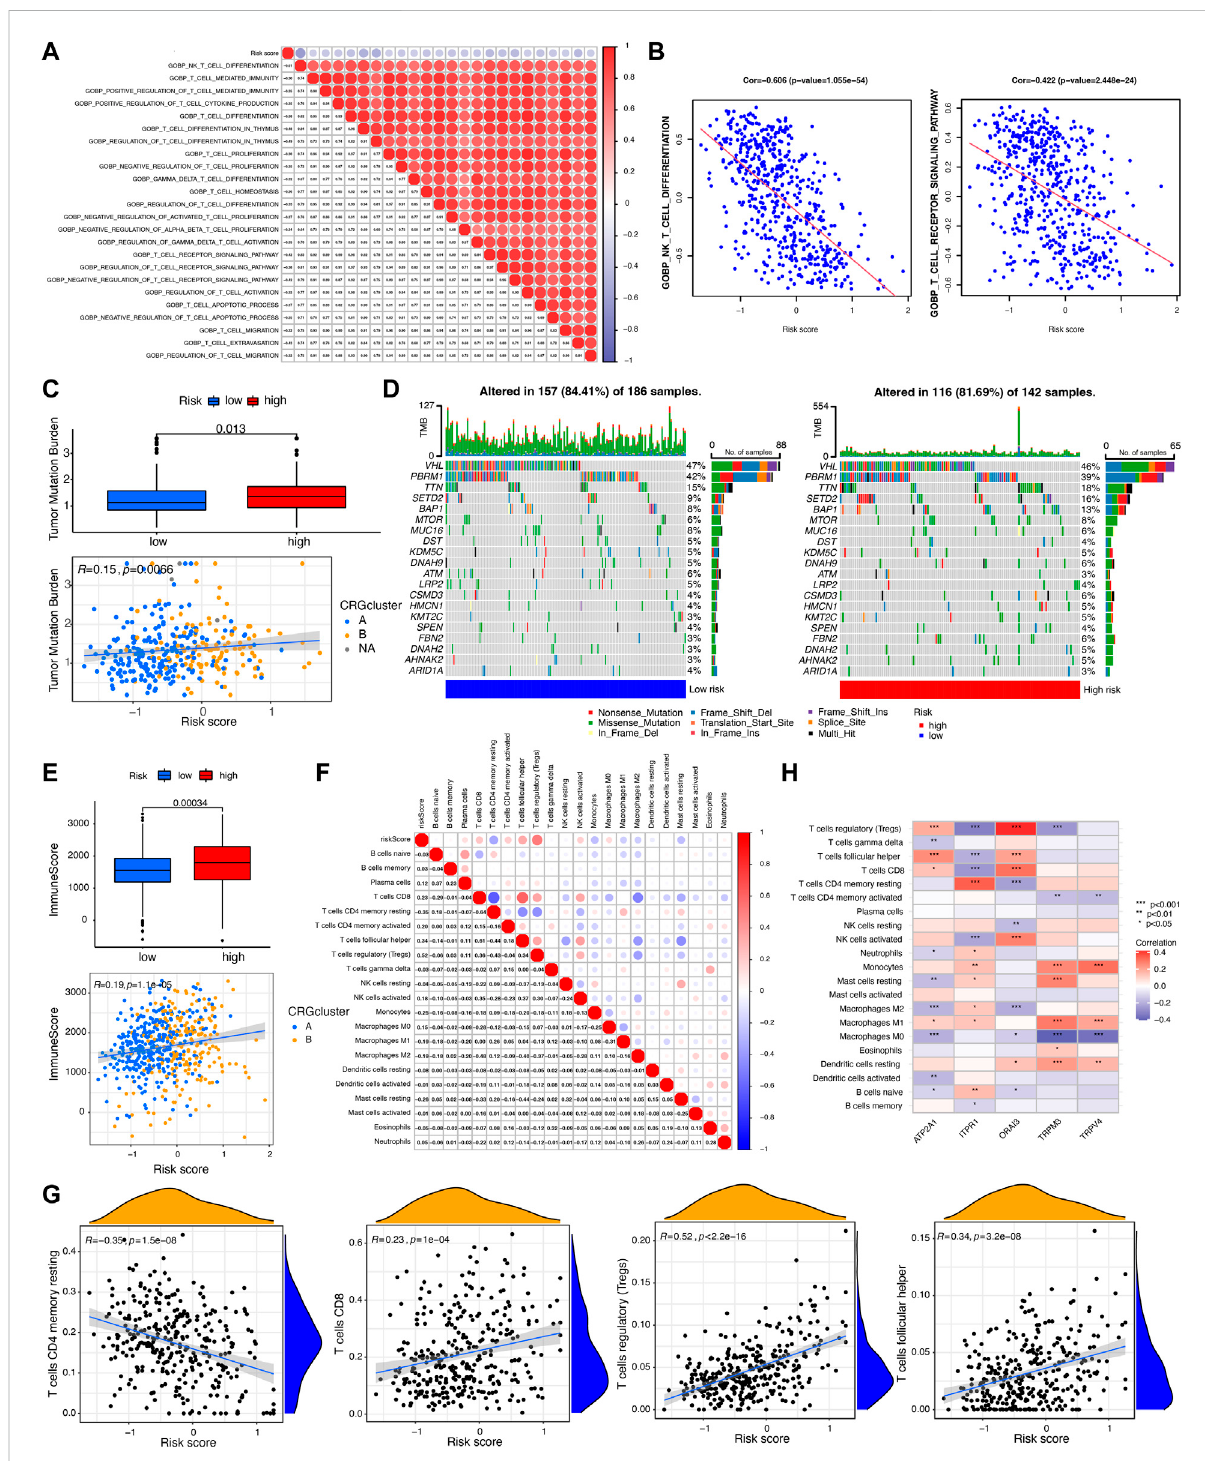
FIGURE 5 Evaluation of tumor mutation burden (TMB) and immune cell in fi ltration between CRGs-related risk subtypes. (A,B) The correlation between T cell-related immune pathways and CRGs-related risk score. (C) Differences in TMB between CRGs-related risk subtypes. (D) Genes with the highest mutation frequency in CRGs-related risk subtypes. (E) Differences in immune score between CRGs-related risk subtypes. (F,G) The correlation between 22 immune cell in fi ltration and CRGs-related risk score. (H) The correlation of fi ve prognostic-related CRGs with immune cell in fi